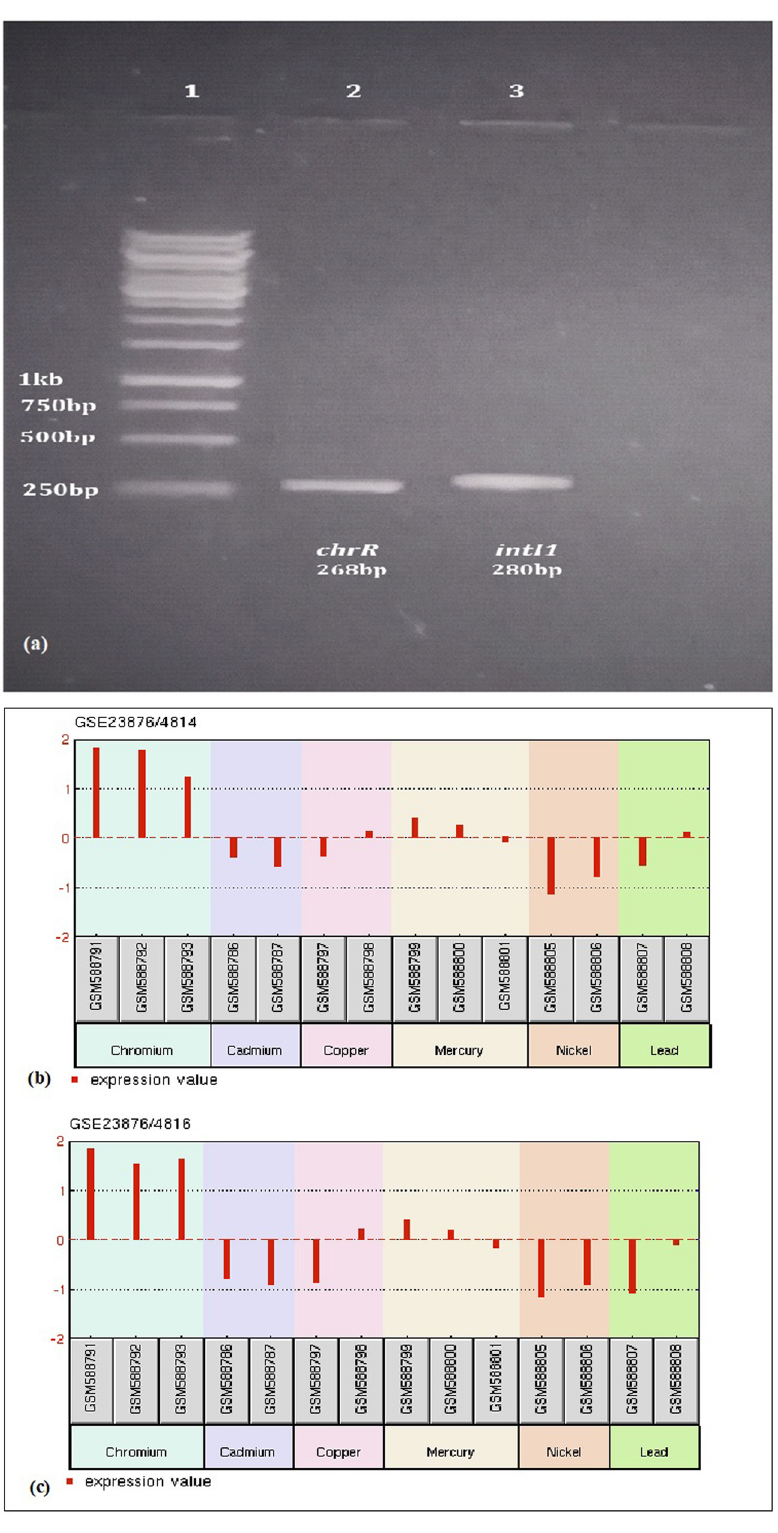
Figure 5: ( a ) Detection of chromate reductase and integrase gene in this study. Lane 1: 1 kb DNA Ladder - Thermo Fisher, Lane 2: Chromate reductase gene chrR 268 bp, and Lane 3: integrase gene intI1 280 bp, ( b ) microarray investigation of cys cluster Rmet_2813, and ( c ) Rmet_2815 in Cupriavidus metallidurans